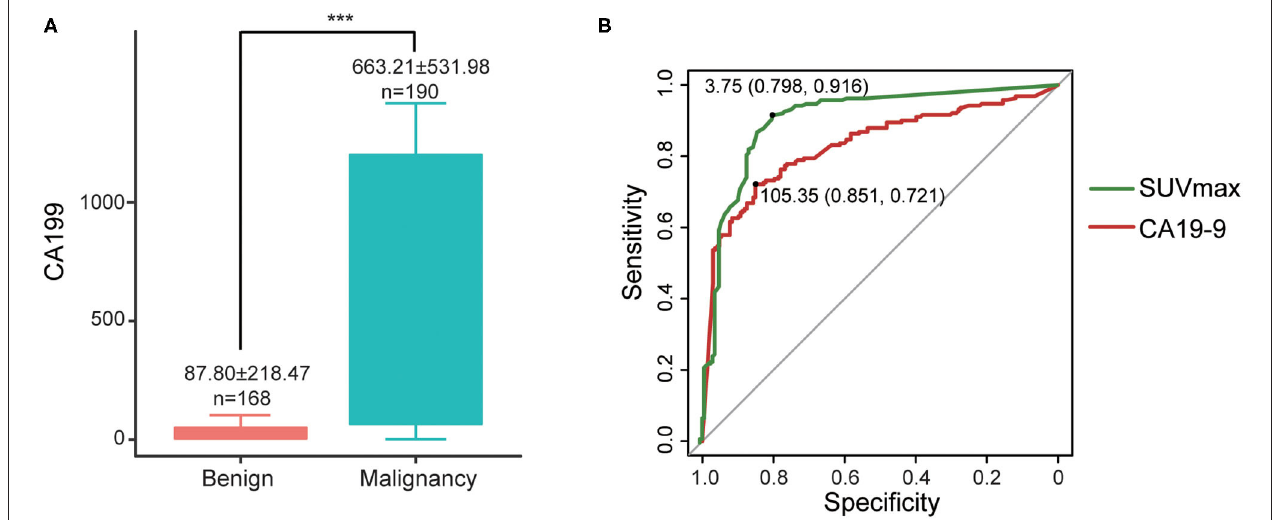
FIGURE 4 | (A) Differences of CA19-9 between malignant and benign groups, *** P < 0.001; (B) ROC curves of CA19-9 and SUVmax.